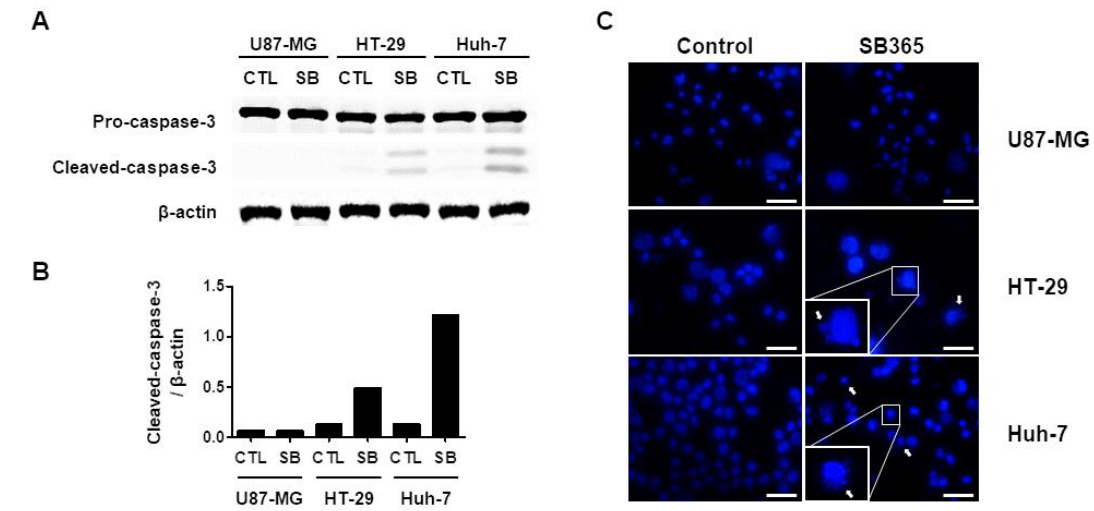
Figure 2. SB365 induced caspase-independent death in U87-MG cells. U87-MG, HT-29 (1 × 10 5 / well), and Huh-7 cells (1 × 10 5 / well) in six-well plates were treated with 10, 5, and 15 µ M SB365, respectively. The calculated IC50 values of SB365 on each cell line were 8.9, 5.1, and 13.2 µ M, respectively. ( A ) Cell lysates were subjected to western blotting of caspase-3 cleavage, ( B ) followed by densitometry. ( C ) SB365 induced nuclear fragmentation in HT-29 and Huh-7 cells, but not in U87-MG cells. Cells were treated with 10 µ M SB365 for 72 h, adhered to an eight-well multispot slide, and stained with DAPI (blue). Arrows indicate fragmented nuclei. Images were acquired using a fluorescence microscope (x 400). The scale bar represents 50 µ m. CTL, control group; SB, SB365-treated group.